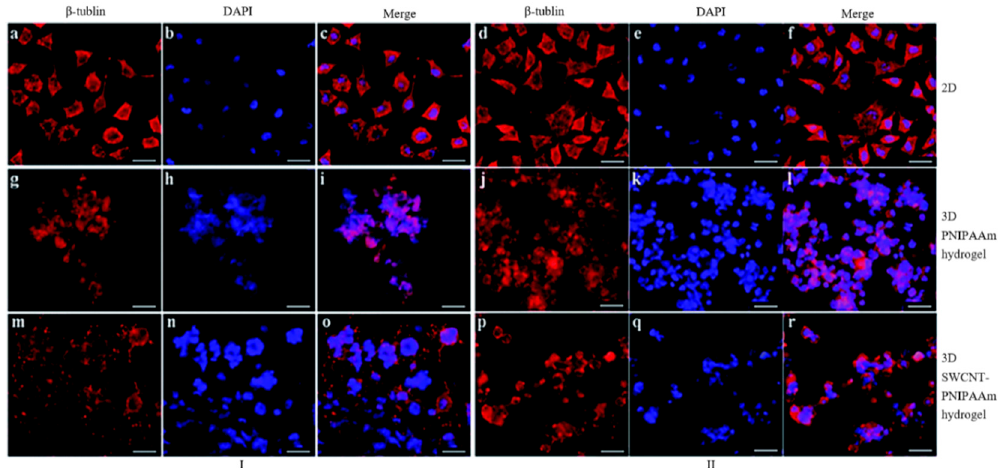
Figure 18. Effects of electrical stimulation (I) on SH-SY5Y cell morphology compared to a group